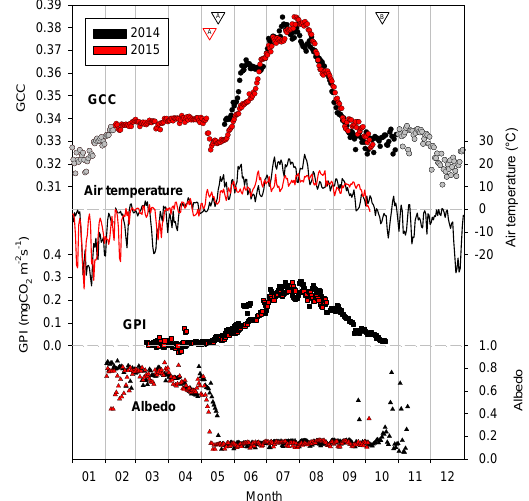
Figure 7. Mean daytime (10:00–14:00, local winter time) GCC (of the ROI shown in Fig. 1b) together with the daily mean air temper- ature, gross photosynthesis index (GPI) and albedo in 2014–2015 at the wetland site. The triangles indicate the dates of snowmelt (A) and snow appearance (B). The grey circles indicate the wintertime data that are influenced by an insufficient light